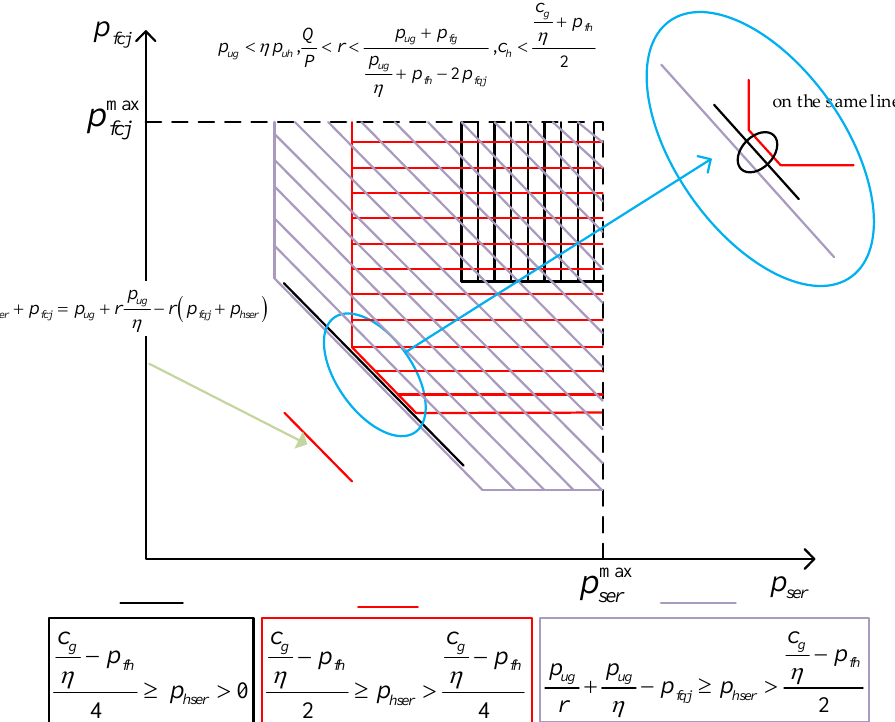
Figure A8. Scenario 8: two-dimensional sketch of the tripartite game Nash equilibria. (e) Scenario 9: p ug < η p uh and r > Q